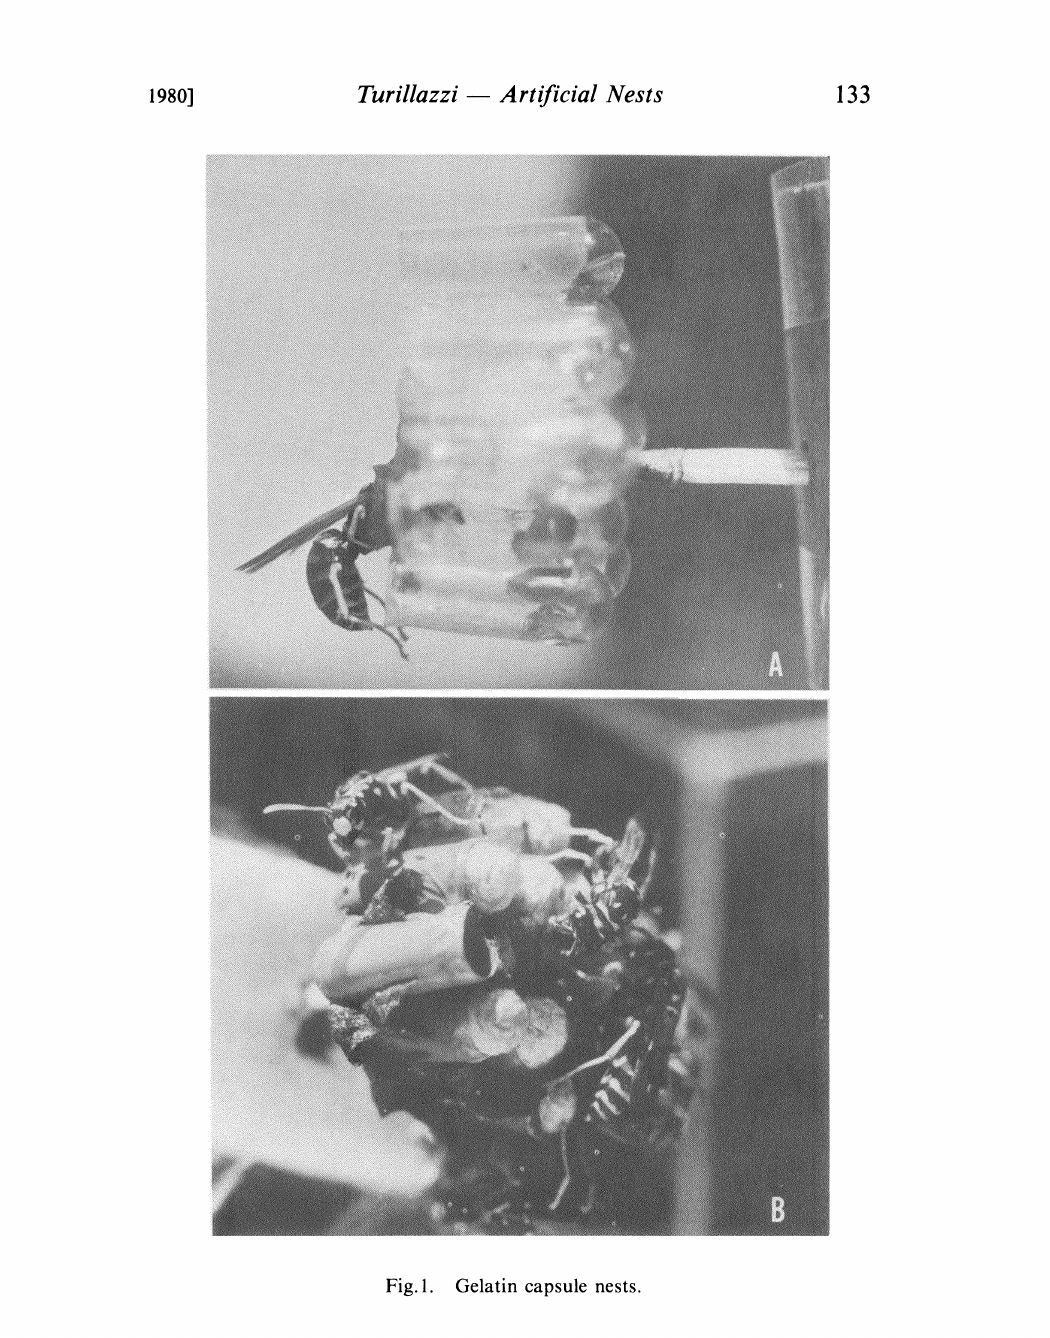
Fig. 1. Gelatin capsule